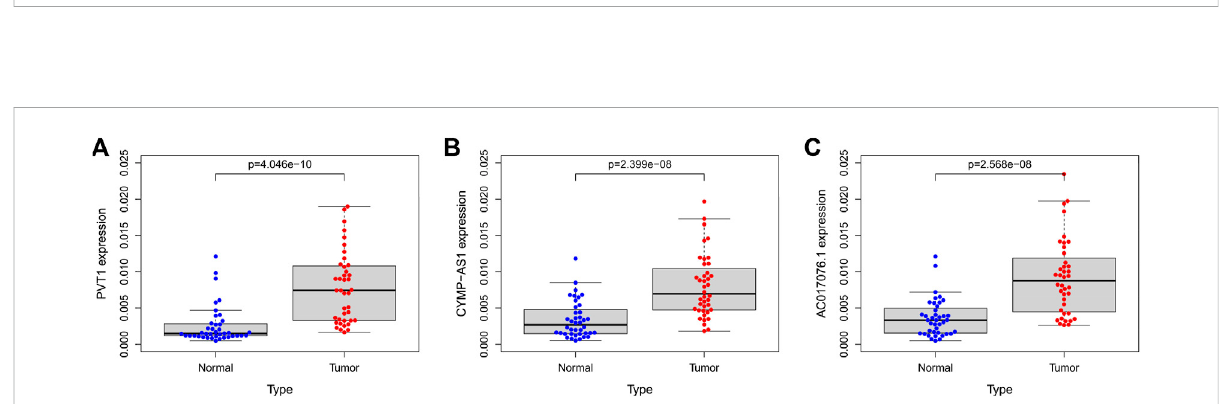
FIGURE 8 (A – C) The expression of lncRNA PVT1, CYMP-AS1, and AC017076.1 in tumor tissues and normal para cancerous tissues of GC patients, respectively. GC, gastric